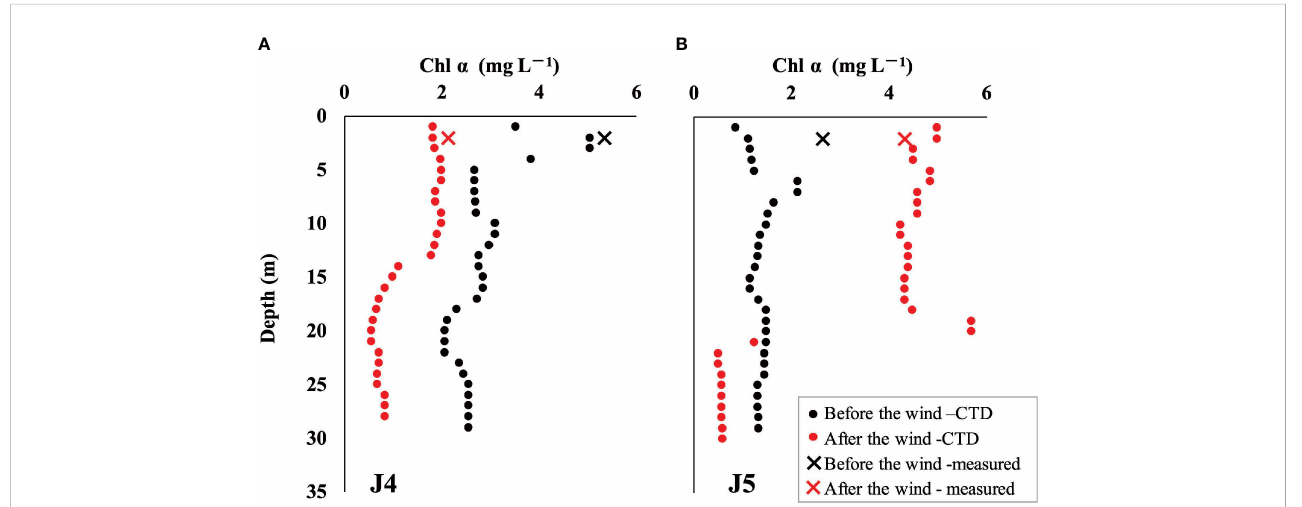
FIGURE 7 Distribution of chl a before and after the wind event: (A) chl a in station J4 and (B) chl a in station J5. The circles represent pro fi le chl a obtained by a submersible fl uorescence probe along with CTD, and the crosses represent surface chl a measured by Turner Design Fluorometer. The black icons represent chl a before wind, while the red icons represent that after